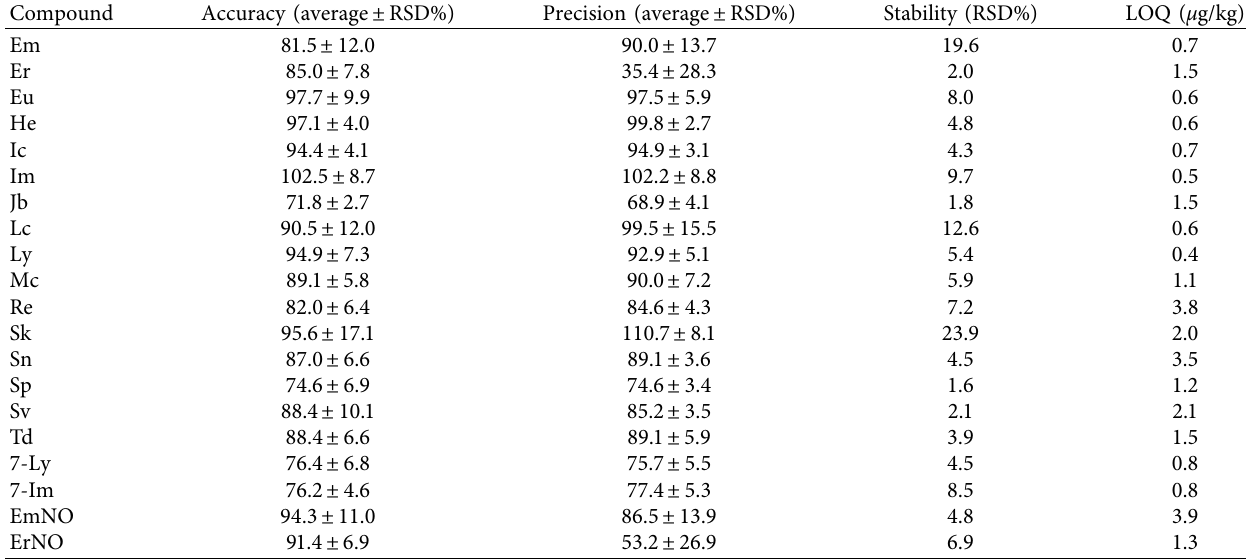
Table 6: Accuracy, precision, stability, and LOQ of